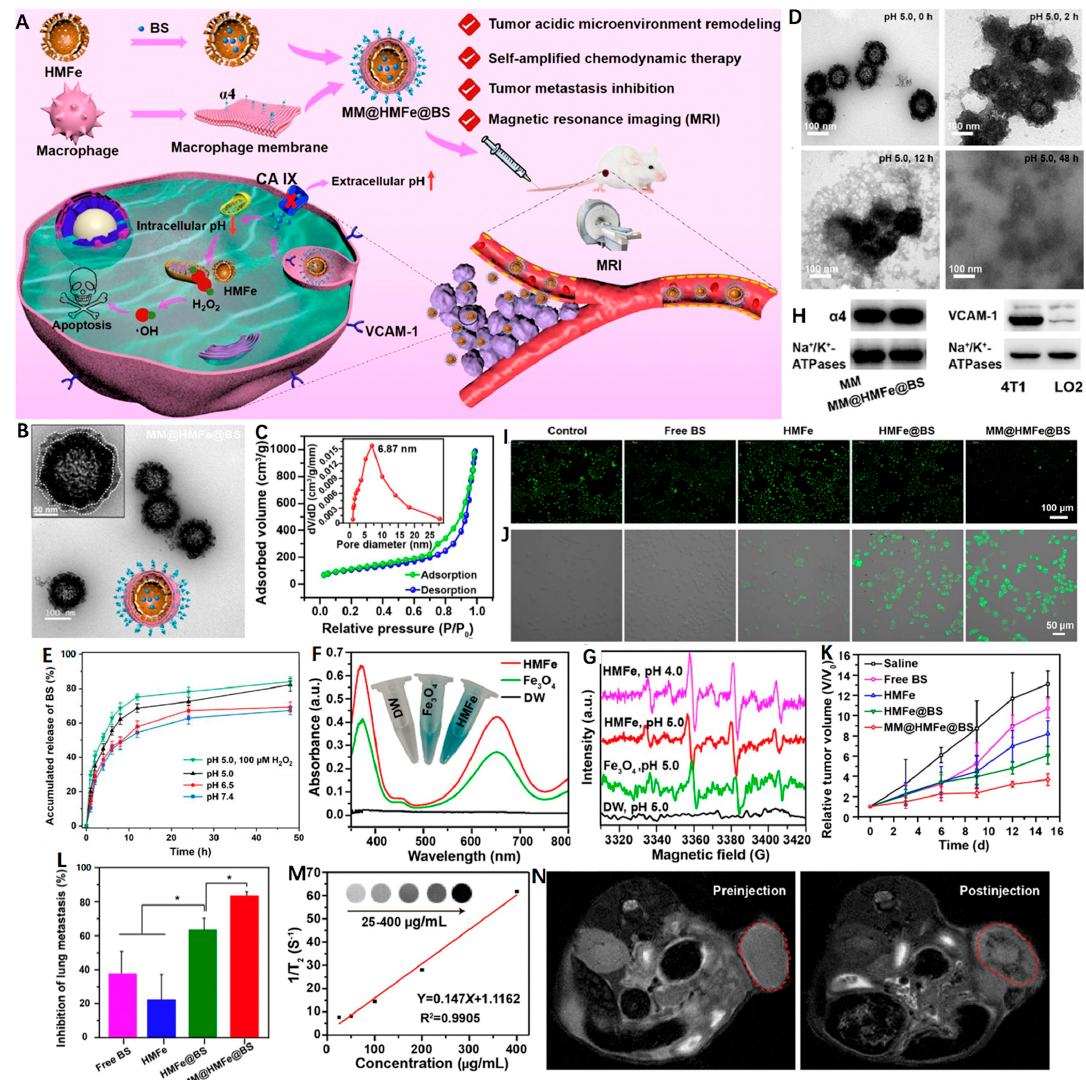
Figure 4. ( A ) Illustration of MM@HMFe@BS for self-amplified chemodynamic therapy and tumor metastasis inhibition via tumor microenvironment remodeling under the monitoring of MRI. ( B ) Representative TEM images of MM@HMFe@BS. ( C ) Nitrogen adsorption − desorption curve of the HMFe. Inset shows the pore size of HMFe. ( D ) Time-dependent decomposition behavior of MM@ HMFe@BS. ( E ) In vitro release profiles of BS from MM@HMFe@BS at various pH values (5.0, 6.5, or 7.4) with or without H 2 O 2 . ( F ) UV − Vis absorption spectra of TMB after coincubation with DW (de- ionized water), solid Fe 3 O 4 , and HMFe in the presence of H 2 O 2 (100 μ M) at pH 5.0. ( G ) ESR spectra of detected •OH at different conditions. ( H ) Western blot analysis of α 4 and VCAM-1 in macro- phage membrane and 4T1 cells membrane, respectively. Fluorescence images of ( I ) BCECF-stained and ( J ) APF-stained 4T1 cells treated with free BS, HMFe, HMFe@BS, and MM@HMFe@BS for 12 h. ( K ) Relative tumor volume changes in 4T1 tumor-bearing mice with different treatments (n = 5). ( L ) Lung metastasis inhibition ratios on the 15th day post-treated with different formulations in contrast to control group (n = 5). ( M ) Linear plot of 1/T 2 as a function of HMFe concentration. The inset is T 2 - weighted MRI images of HMFe. ( N ) In vivo MRI of 4T1 tumor-bearing mice before and after intra- venous injection of MM@HMFe@BS. Reprinted with permission from Ref. [99]. Copyright 2022, American Chemical Society. * p < 0.05.